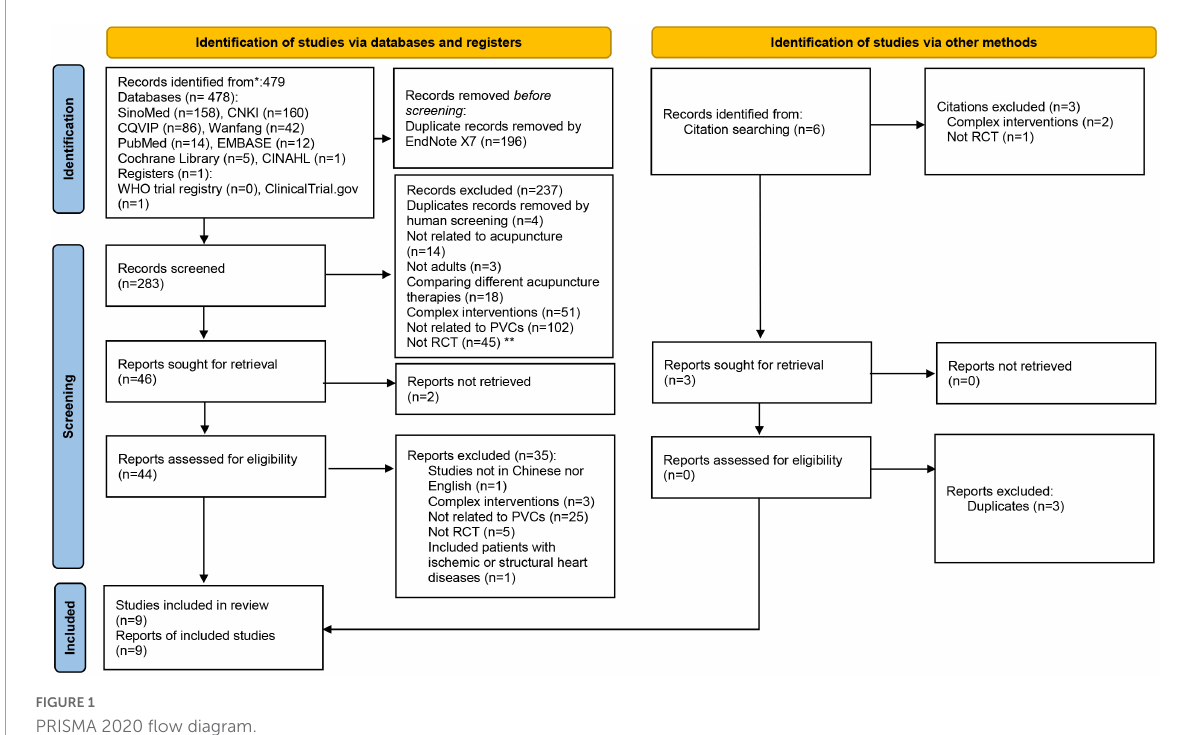
FIGURE1 PRISMA 2020 flow